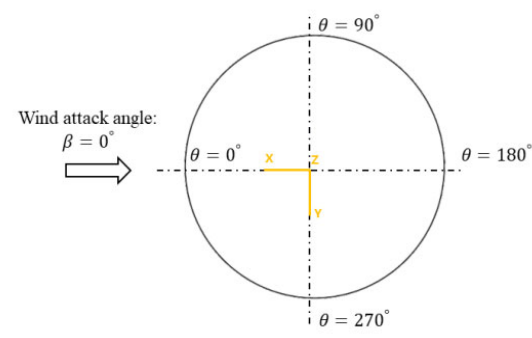
Figure 12. Illustration of the wind attack angle.